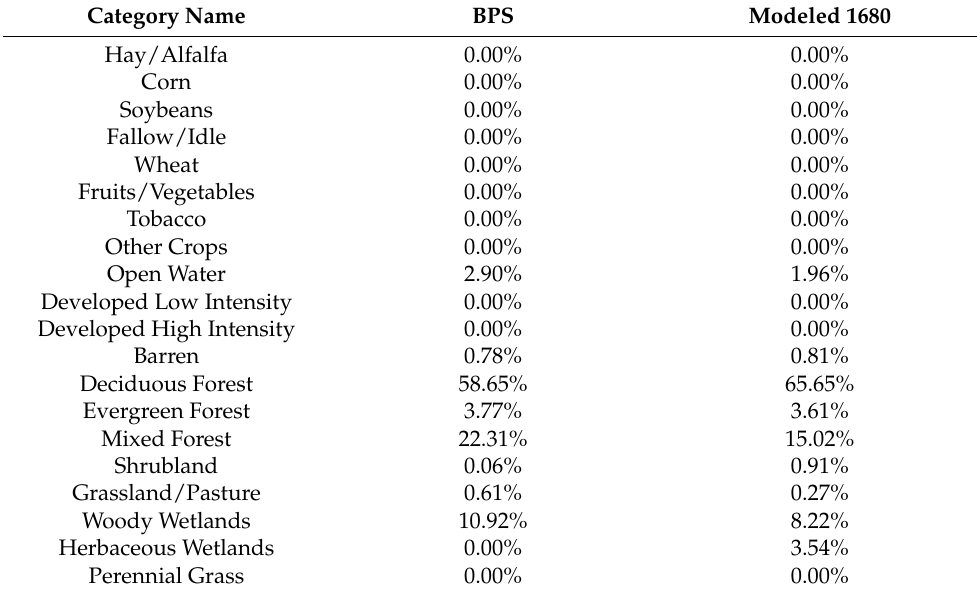
Table 6. Modeled land cover at 1680 vs. LANDFIRE BPS pre-settlement dataset